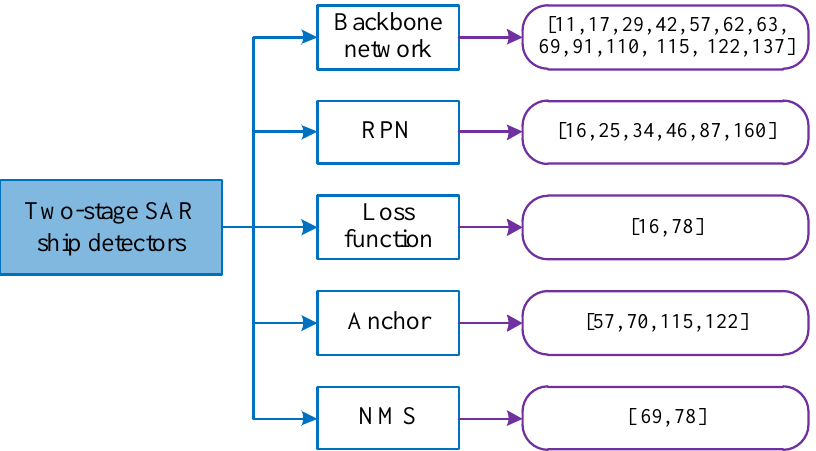
Figure 7. The two-stage SAR ship detectors.